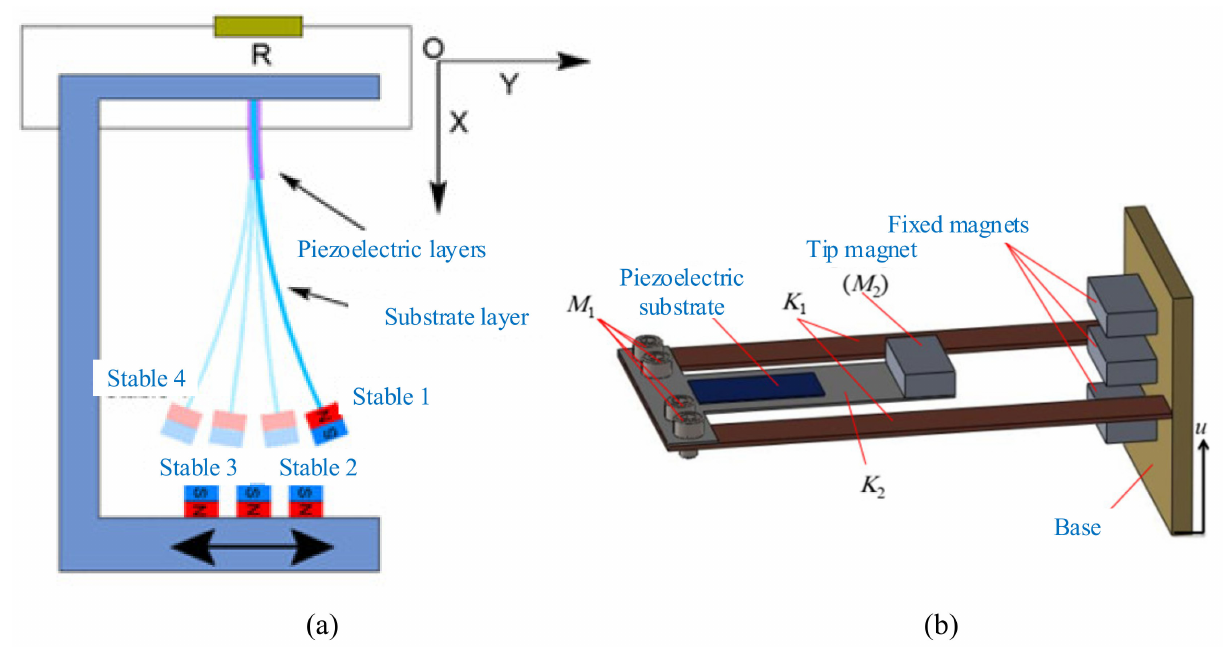
Figure 12. Some existing quadstable harvesters. ( a ) A quadstable harvester with one degree of freedom (reproduced with permission from [170]; published by Elsevier, 2018). ( b ) A quad-stable harvester with two degrees of freedom (2-DOF) (reproduced with permission from [171]; published by MDPI,